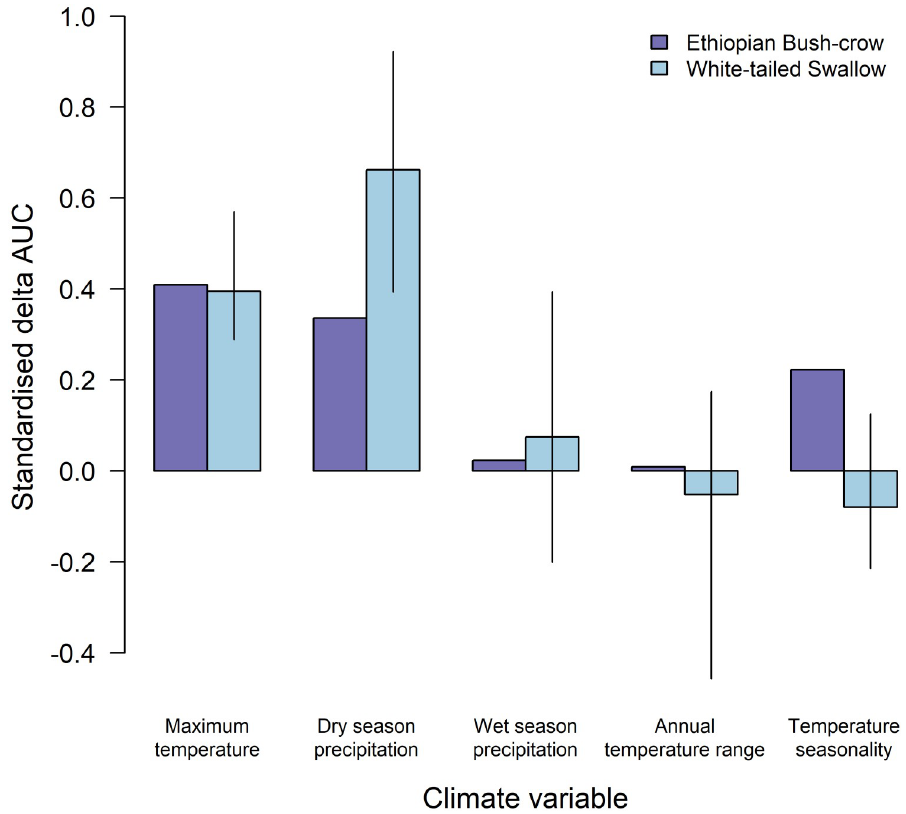
Fig 2. Comparison of the relative importance of five bioclimate variables in models describing the geographical range of the Ethiopian Bush-crow (taken from [12]) and White-tailed Swallow. For the bush-crow, bars represent standardised delta AUC scores from the model fitted using the algorithm which gave the best fit (boosted regression trees). For the swallow, bars represent the mean standardised delta AUC scores from the three best-performing models (Maximum Entropy, Generalised Linear Models, Generalised Additive Models), which were indistinguishable based on their k -fold LOOCV AUC scores. Lines represent the range of standardised delta AUC scores from the three algorithms for the